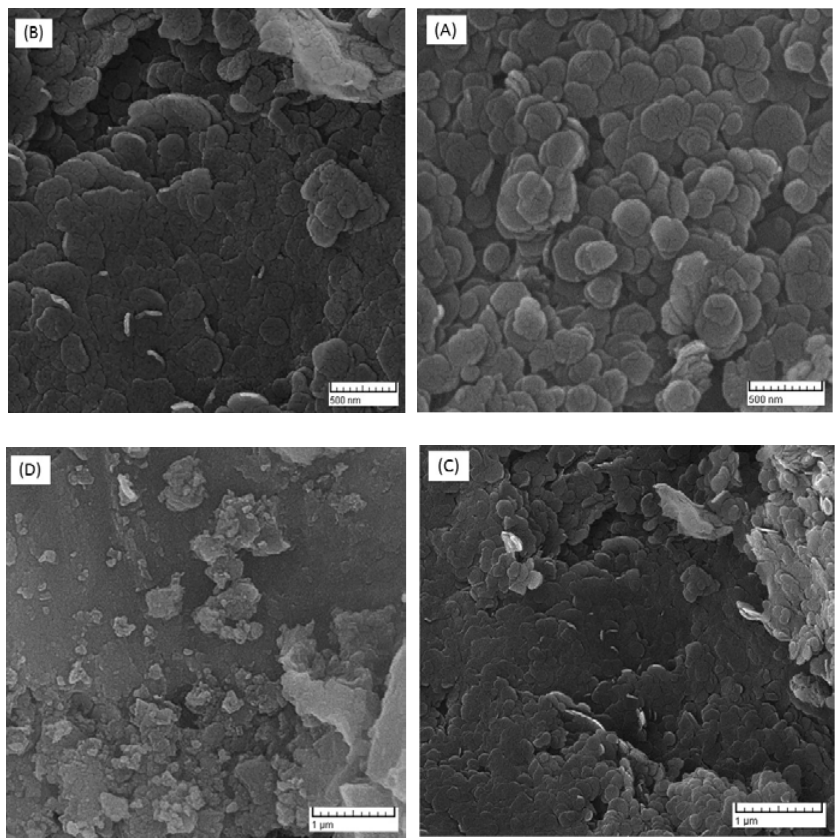
Fig. 2: SEM images of synthesized LDHs: (A) Mg-Al (4:1), (B) Mg-Al (3:1), (C) Zn-Al (4:1), and (D) Zn-Al (3:1)